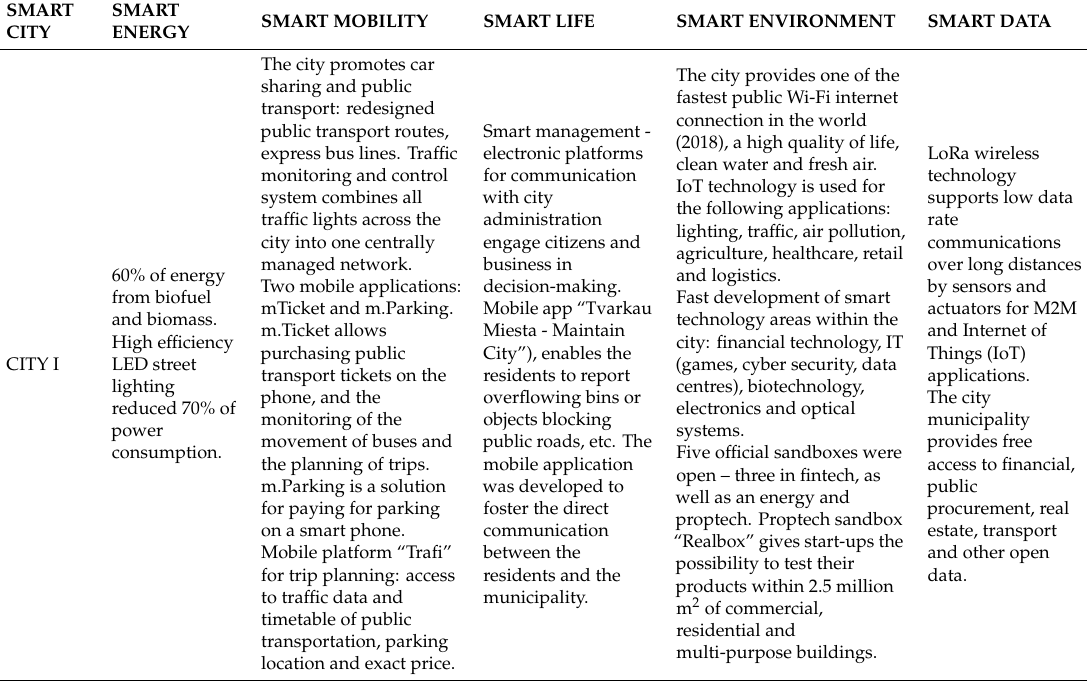
Table 11. Analysis of Smart City I [41,42].